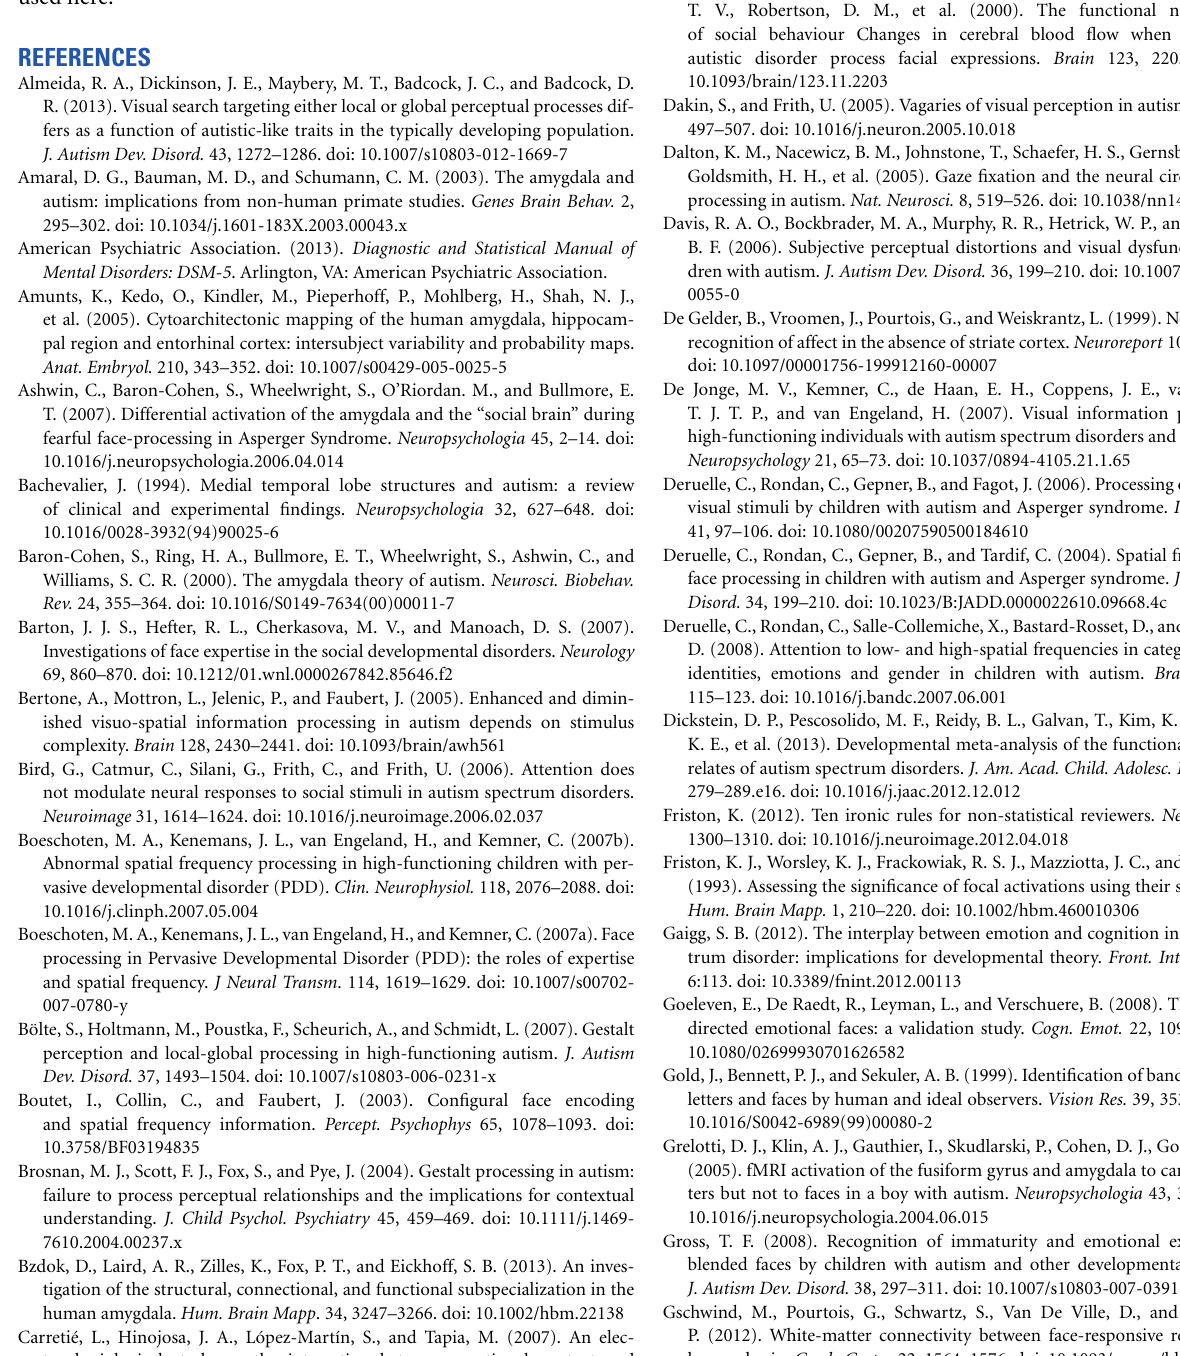
( Figure 8 ) can only be taken as evidence for spared functional- ity of the cortical path outside the demands of the discrimination task (see Discussion section above). Future studies will need to extend these results by using other tasks in which participants are forced to focus on local facial details, thus allowing us to determine the neural signatures associated with featural facial processing in addition to the frequency content manipulation used